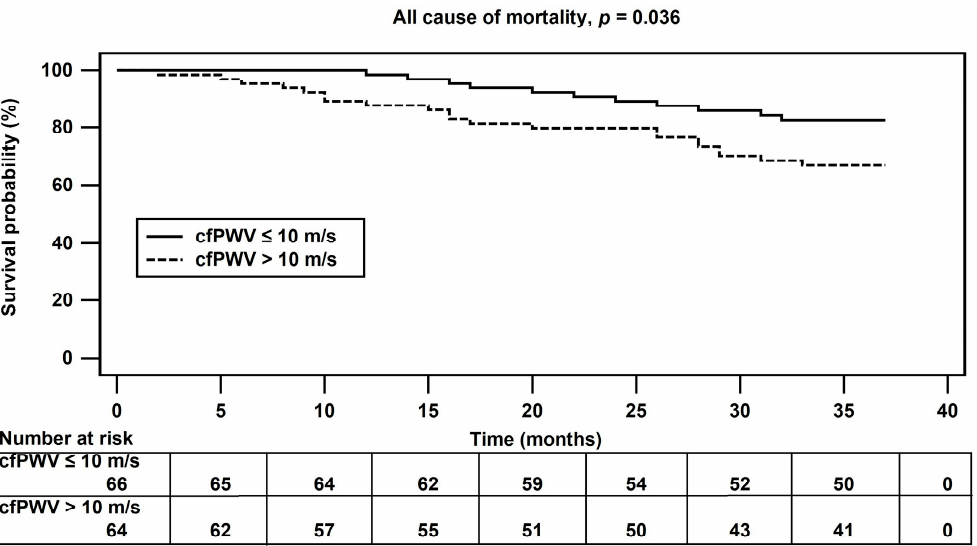
Figure 1. Kaplan–Meier analysis of carotid–femoral pulse wave velocity levels and all-cause mor- tality events in hemodialysis patients.